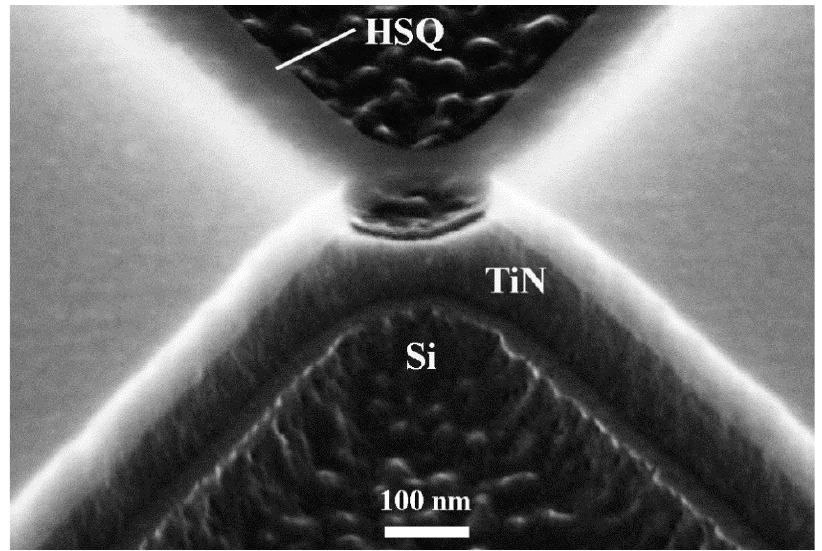
Figure 6. High-resolution SEM image of a TiN nanobridge Josephson junction (JJ) recorded at a 45° sample tilt angle.